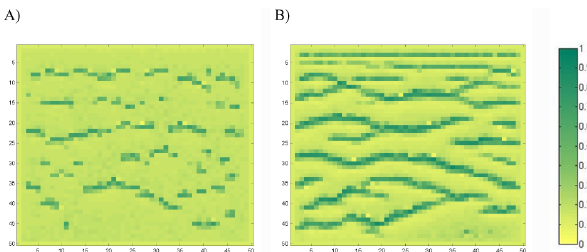
Fig. 20. Effect of soil moisture redistribution due to roots on pattern formation. (A) No roots redistribution. (B) Roots are able to reroute the soil moisture from adjacent less vegetated